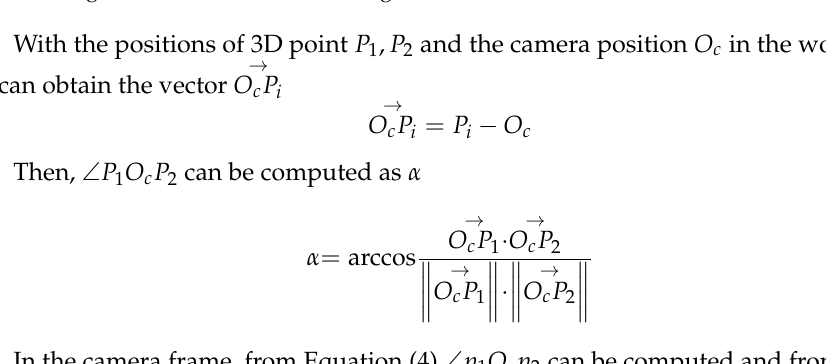
Figure 2. Angle constraint for the focal length